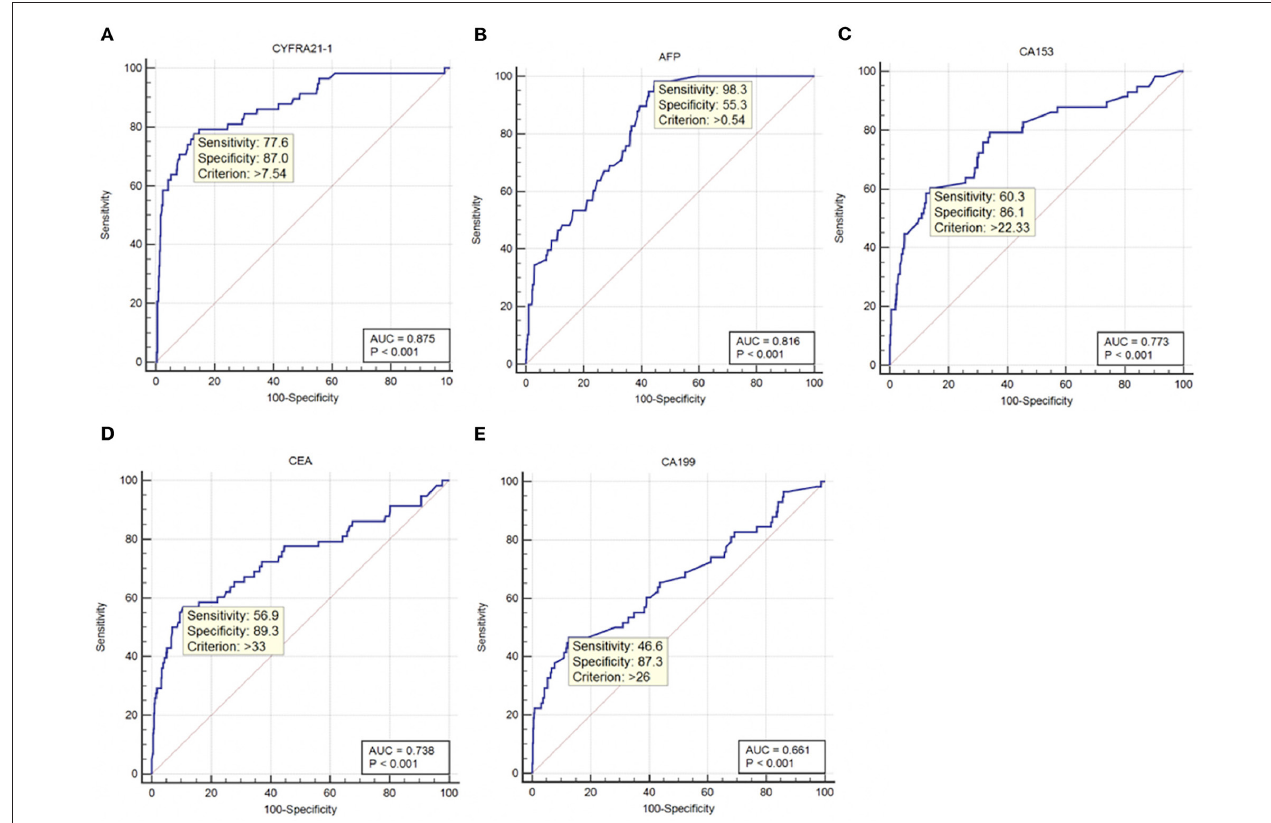
FIGURE 4 | ROC curves for individual tumor markers as independent risk factors. (A) CYFRA21-1. (B) AFP. (C) CA-153. (D) CEA. (E) CA-199. ROC, receiver operating characteristic; AUC, area under the ROC curve; CYFRA, cytokeratin fraction; AFP, alpha fetoprotein; CA, cancer antigen; CEA, carcinoembryonic antigen.